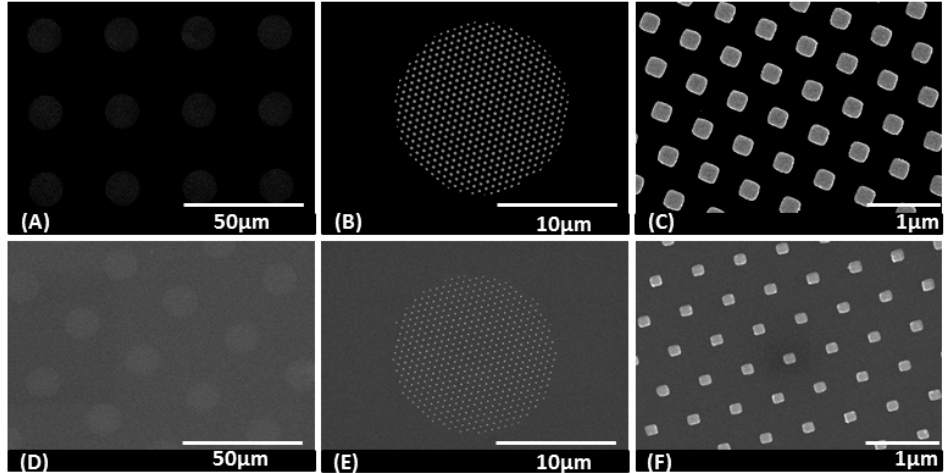
Figure 7. ( A – C ) SEM images of fabricated Au nanodots on a pieces of Si substrate using a polymer membrane with a combination of micro- and nano-holes as a stencil at different magnifications. The size of the Au dots is around 250 × 250 nm 2 and 30 nm in height. ( D – F ) SEM images of fabricated Pd nanodots on a piece of Si substrate using a polymer membrane with a combination of micro- and nano-holes as a stencil at three different magnifications. The size of the Pd is about 130 × 150 nm 2 , with a height of 30 nm.